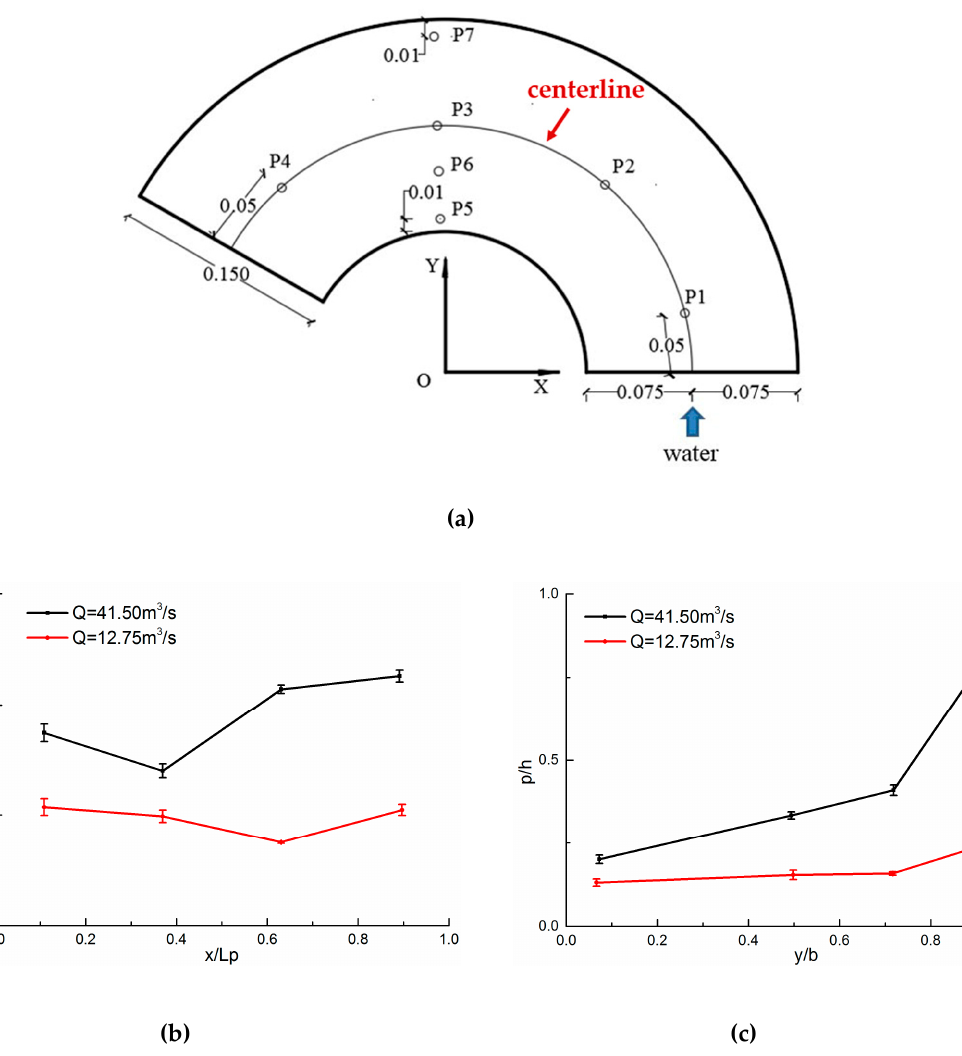
Figure 4. Comparison of numerical and experimental data: ( a ) location of the measuring points (m); ( b ) pressure distribution along the flow direction; ( c ) pressure distribution along the radical